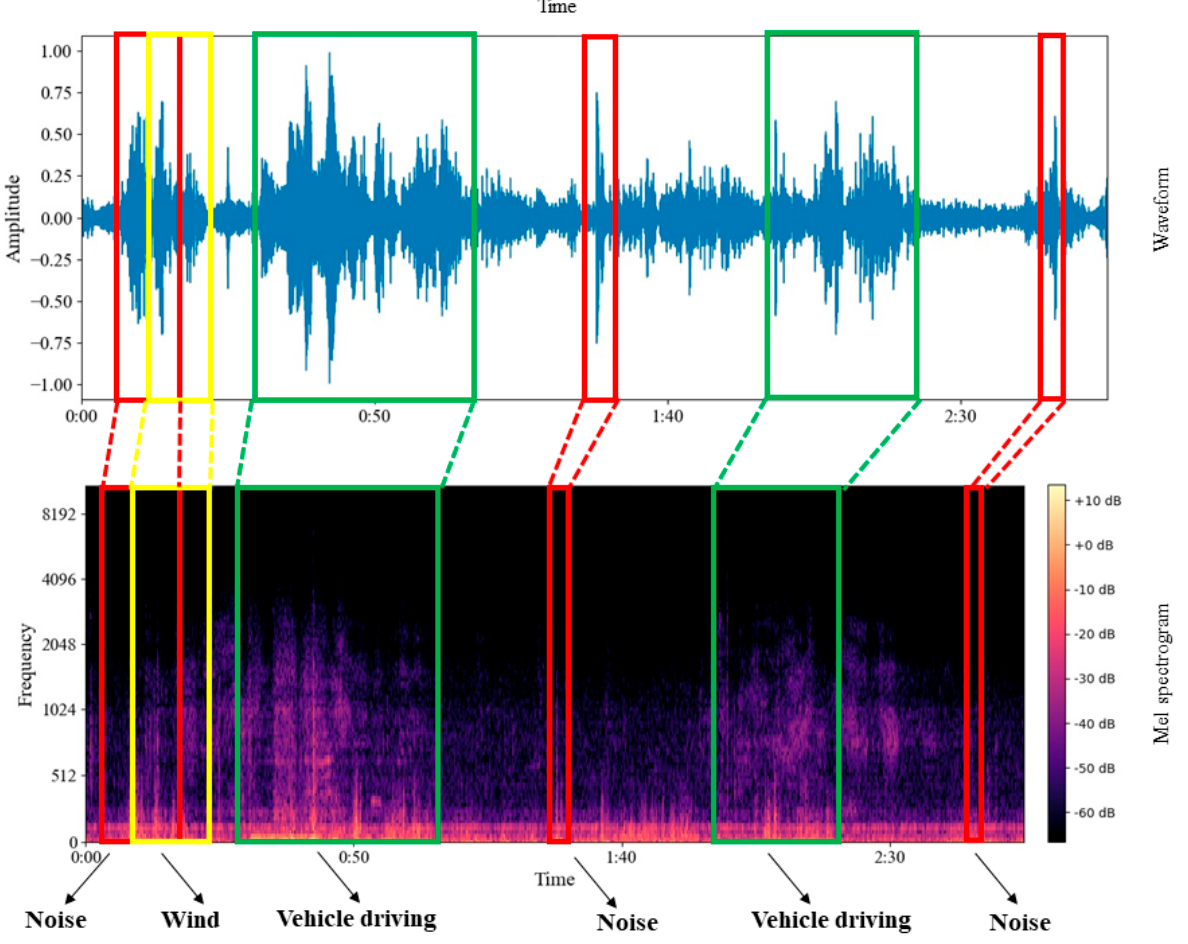
Figure 1. Audio schematic of rainfall scenario.